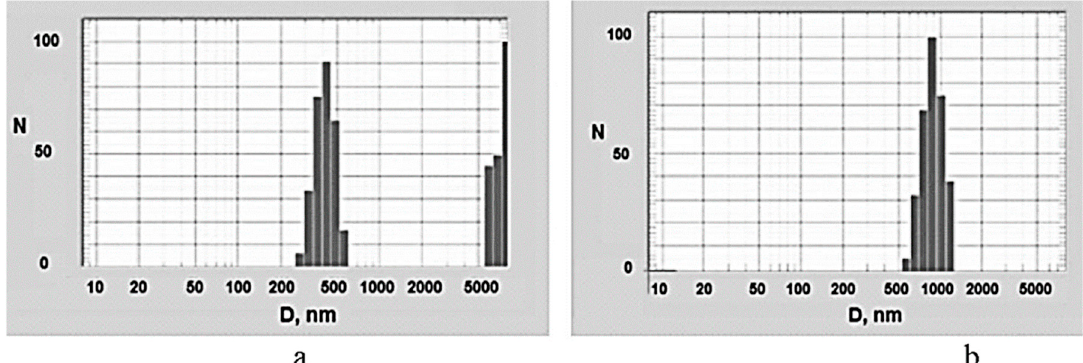
Figure 5. Relative amount N of agglomerates versus effective agglomerate size D (nm) for ( a ) pristine MWCNTs and ( b ) APTES-treated MWCNTs in epoxy resin diluted with isopropanol. MWCNTs concentration was equal to 0.1 wt %.